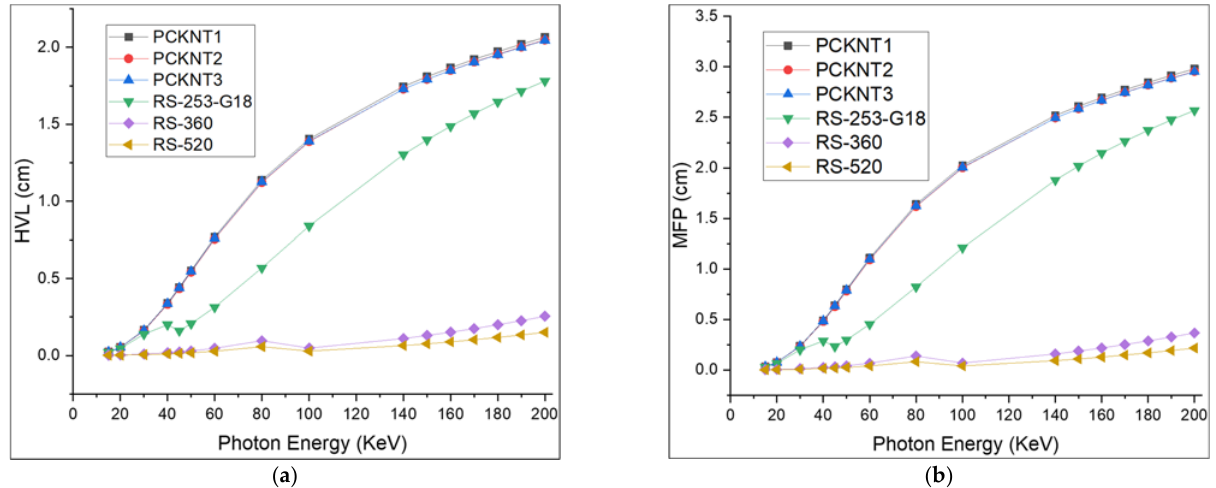
Figure 7. The shielding parameters for TPNK and standard materials: ( a ) HVL and ( b ) MFP. Table 5. Half-value layer, tenth value layer, and the mean free path of prepared PCKNT glasses.